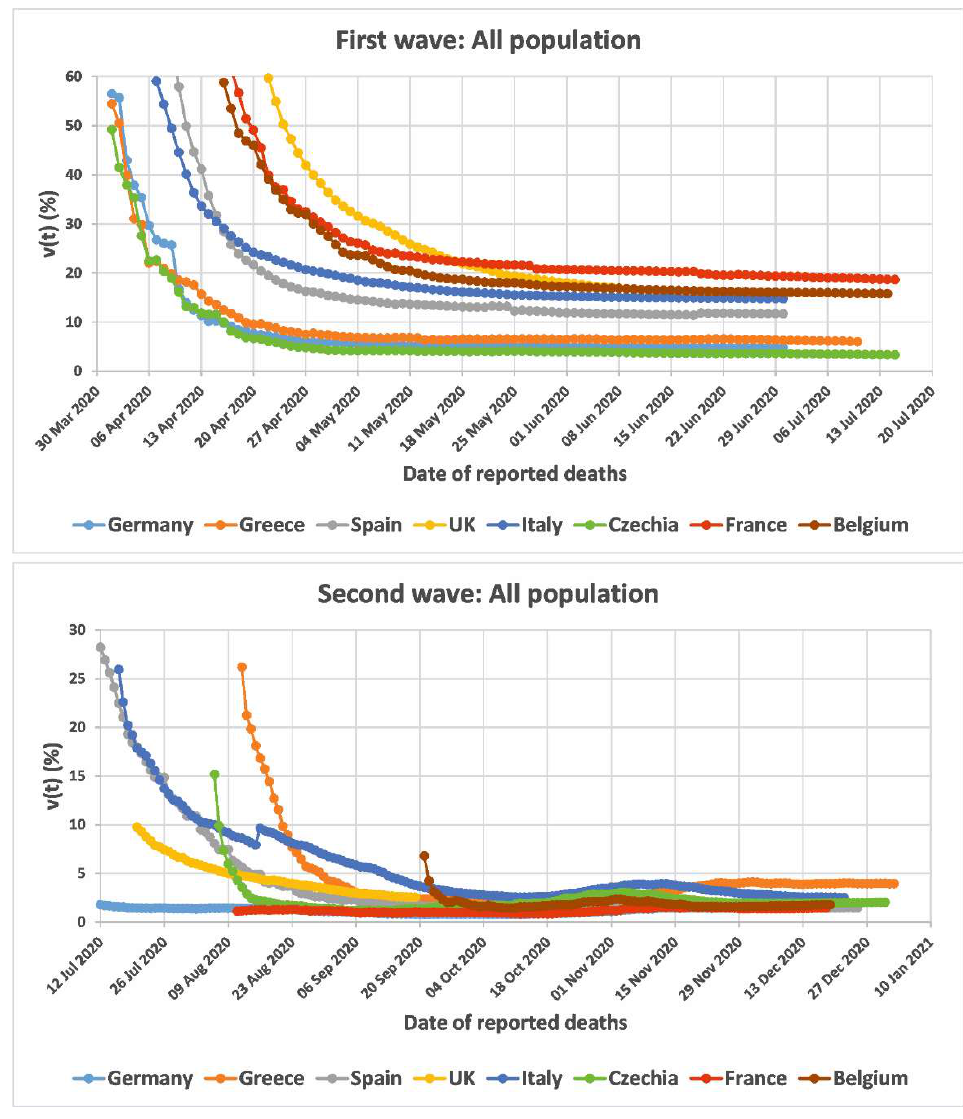
Figure 4. The function v(t) for the entire population of Germany, Greece, Spain, UK, Italy, Czechia, France, and Belgium for the first and second waves. Table 1. Stabilization values for the function v(t) for the first and second waves, for various countries, for all